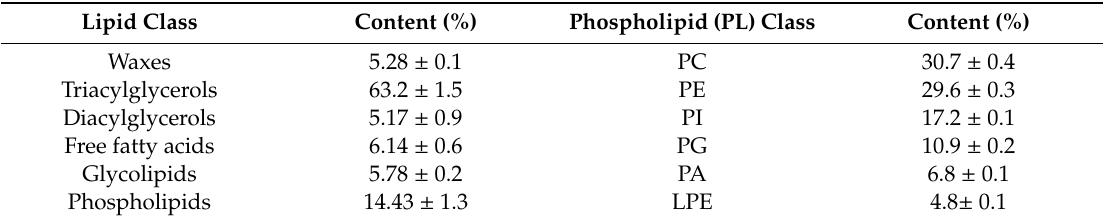
Table 1. Lipid class composition (% of total lipid) and Phospholipid (PL) class (% of total Phospholipids) obtained from Madhuca ellitica seeds.